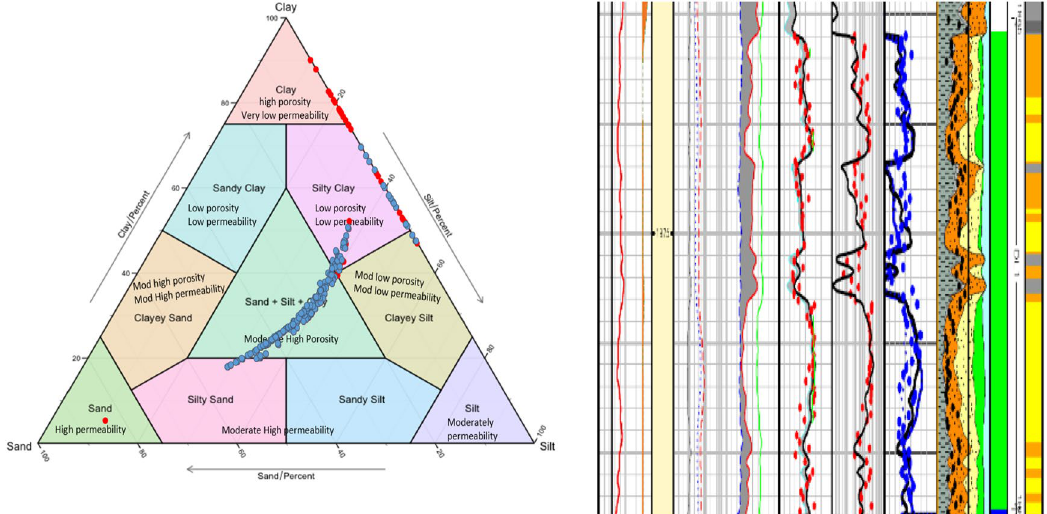
Fig. 14 Ternary diagram for the cored interval in the study